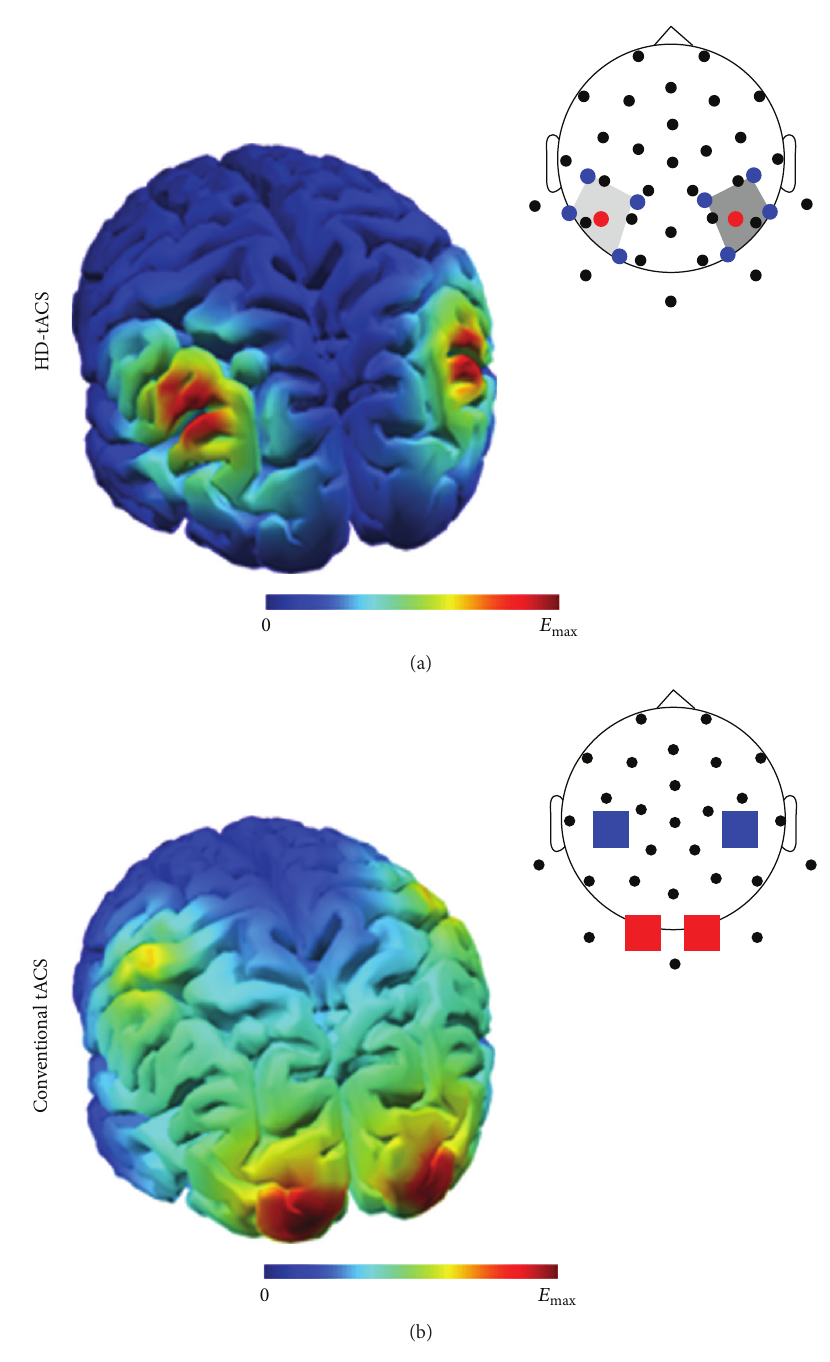
Figure 3: Different montages result in different patterns of current densities. (a) tACS with two 4 × 1 electrode montages (high density, HD) was used in order to achieve a more focal current density. (b) Trying to achieve a similar pattern of current flow with conventional large electrodes results in a more widespread distribution of currents. Reprinted with permission of the authors from [27]. Table 1: Translating a current strength of tDCS/tACS (left column) into a voltage gradient (right column) that is used in animal studies. At first, an intracranial current density must be computed in a simulation. If this is multiplied by the gray matter resistivity it yields the voltage